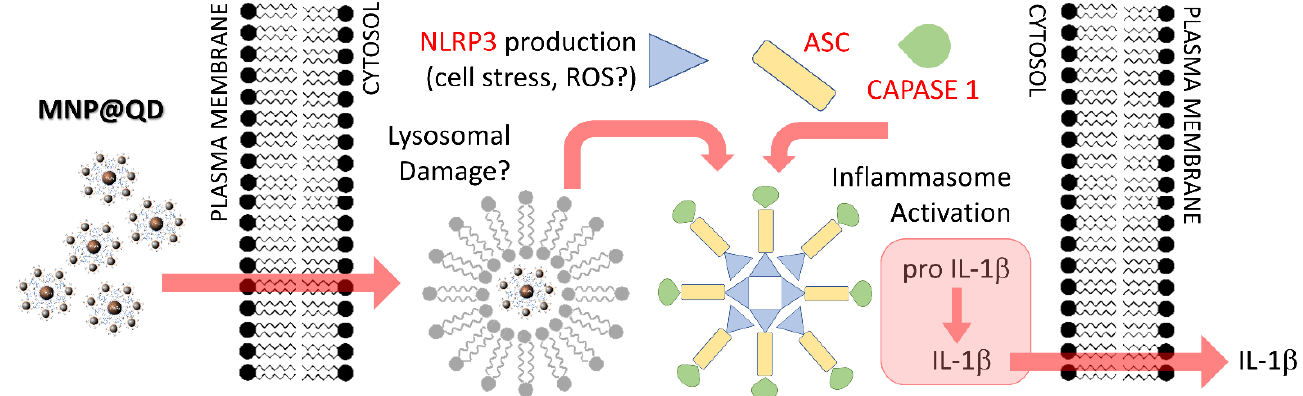
Scheme 1. Illustrative representation of NLRP3 inflammasome activation in Murine Bone Marrow- derived Dendritic Cells after stimulation with MNP@QD, resulting in IL- 1β secretion. Further